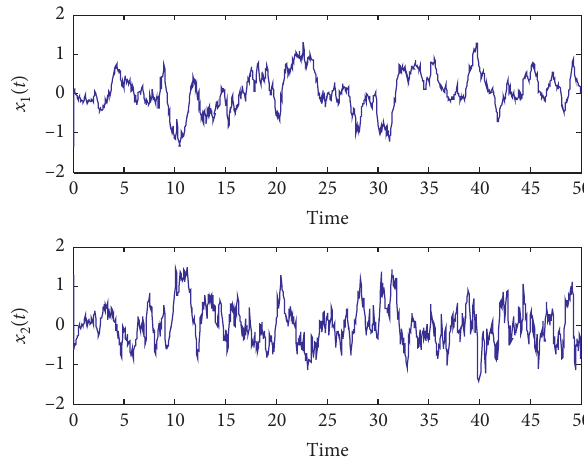
Figure 6: State trajectories of the